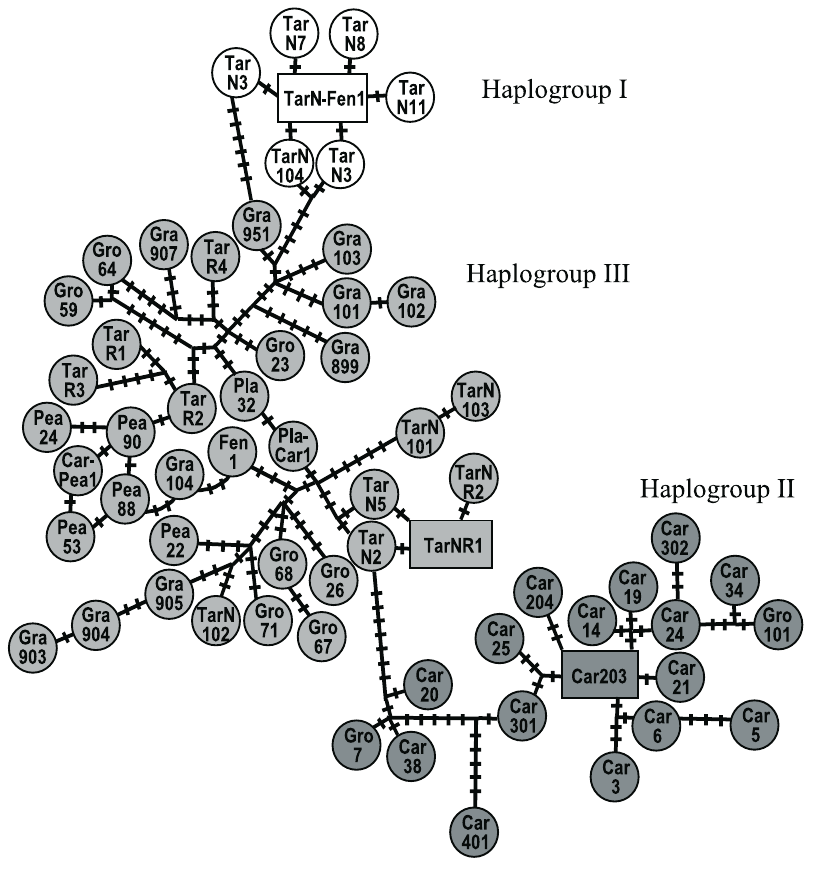
Fig. 4. Minimum spanning network (MSN) of mtDNA haplotypes of reindeer and caribou ( cf. Flagstad & Røed, 2003). Each haplotype is given a three-letter code according to subspecies origin. Norwegian and/or Russian origin of tarandus (Tar) haplotypes is indicated by capital letter N and R, respectively. Bars displayed perpendicular onto the lines connecting the haplotypes represent mutations. Haplogroups I, II and III are indicated with white, dark grey and ligther grey, respectively. Haplotypes estimated to be the most likely common ancestor within each of the three haplogroups are displayed as